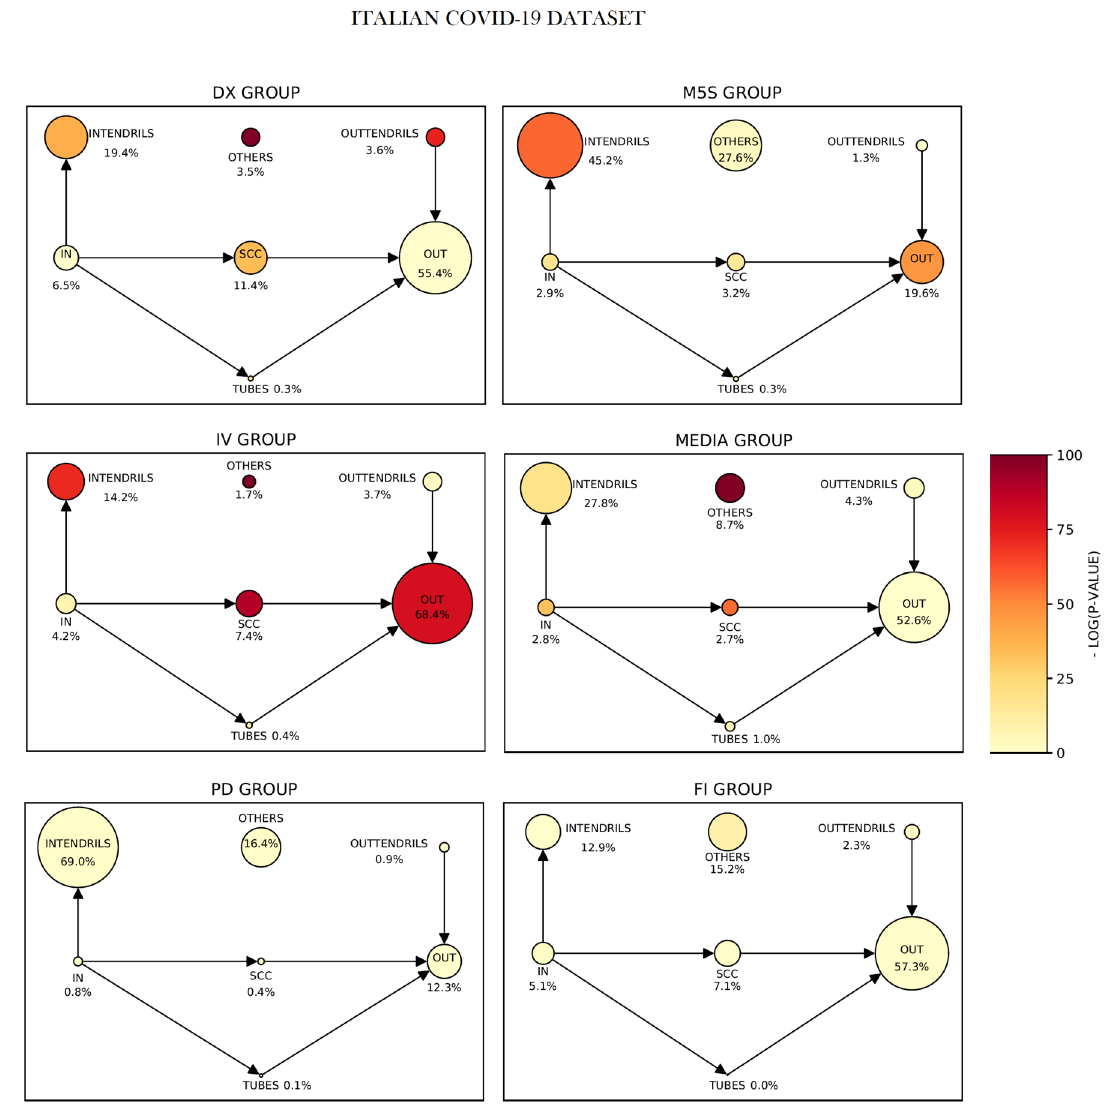
Figure 3. The bow-tie structure of the discursive communities in the Italian COVID-19 dataset. The dimension of the sectors is proportional to the number of nodes: DX and IV discursive communities have strong bow- ties (the OTHERS block is smaller than SCC), while the others are weak (the OTHERS block is greater than SCC, still being smaller then bow-tie WCC). The DX, IV, FI and MEDIA groups display a OUT-dominant bow-tie structure, with the most part of the nodes located in the OUT sector. M5S and PD communities have a INTEND-dominant bow-tie structure, the INTENDRILS sector being the dominant one. The colour of the blocks quantifies the distance between the observed dimensions and those predicted by the Direct Configuration Model (DCM). The observed dimension for the OTHERS sector is significantly less numerous (considering a significance level at α = 0.01 ) for all the communities, but PD. Remarkably, for INTEND- dominant bow-ties, also other sectors, as SCC and INTENDRILS, are usually bigger than what we expect from the SCC is statistically significant (and bigger than expected) for all bow-ties but FI and PD. The IN block is often statistically significant and smaller than expected. We may notice that in the strong bow-tie of IV discursive community the dimensions of all sectors are statistically significant, while none are in the PD bow-tie, which is the smallest discursive community. It is worth noting that also the dimension of the discursive community has